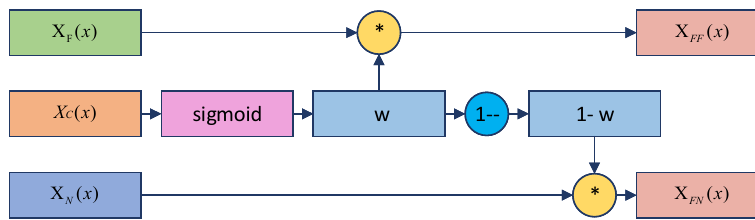
Figure 5. Fuse block coupling calculation process.